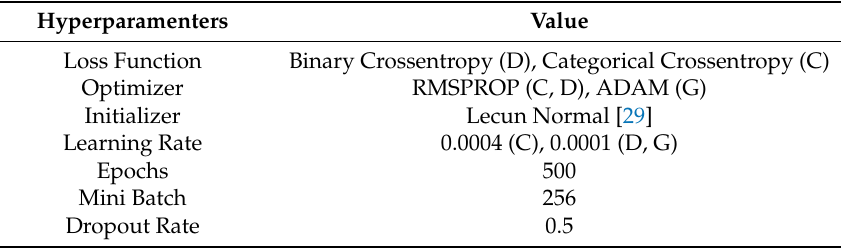
Table 4. Hyperparameters in SCGAN training.